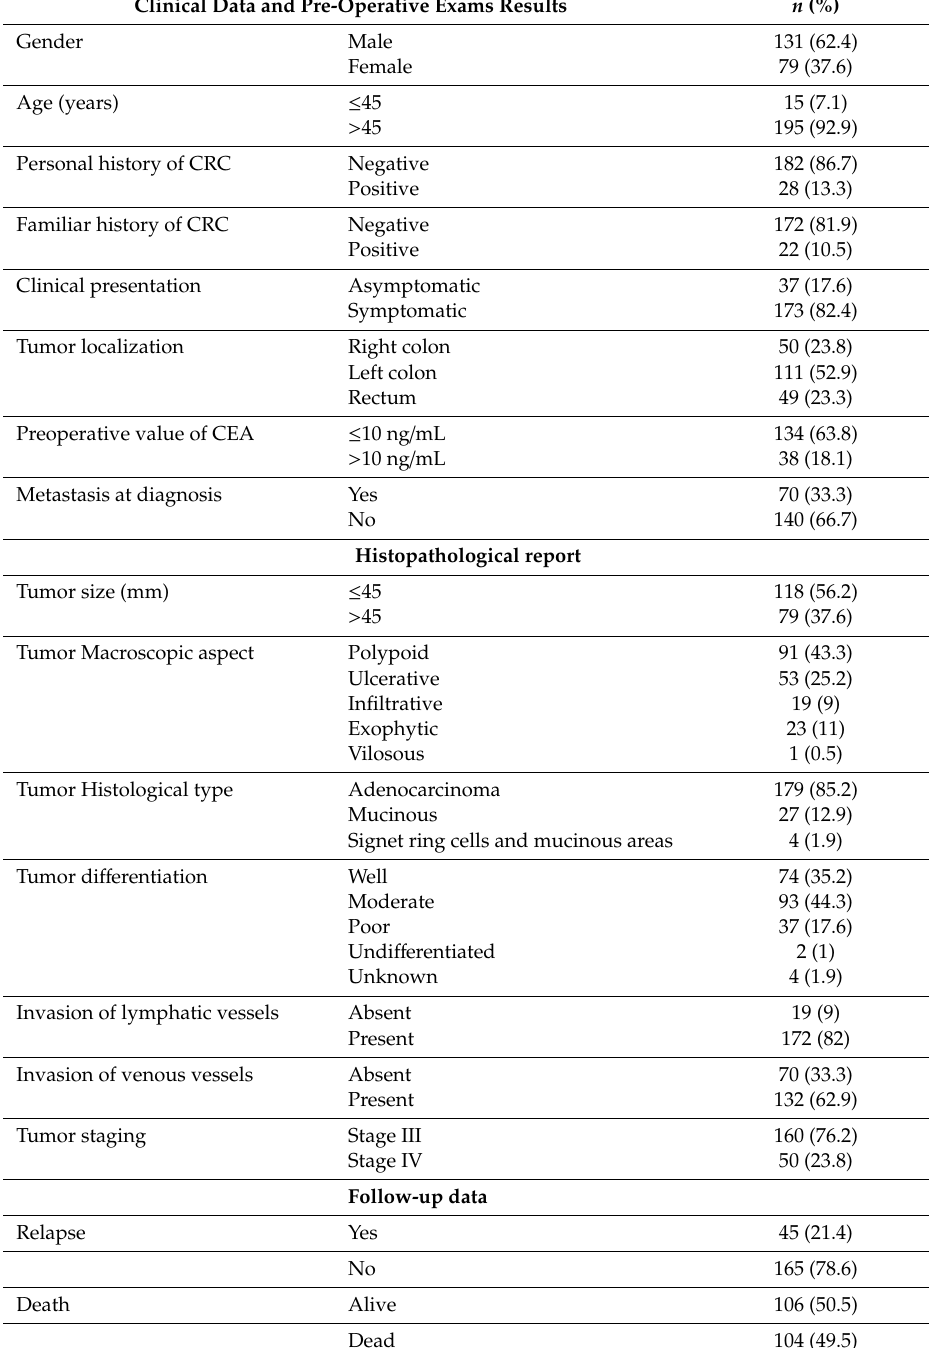
Table 1. Clinicopathological characterization of